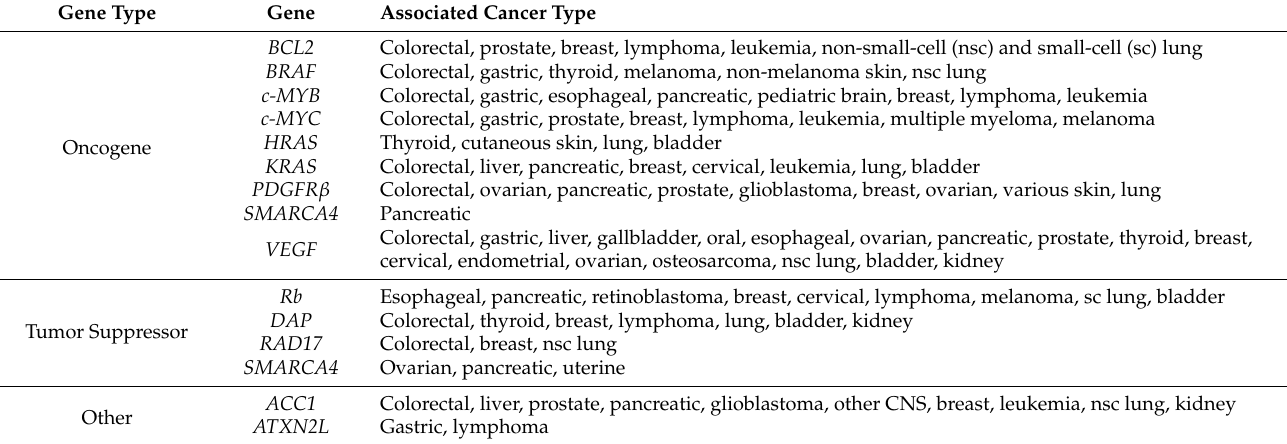
Table 1. Oncogenes, tumor suppressors, and other cancer-related genes with promoter i-motif-forming sequences. Gene